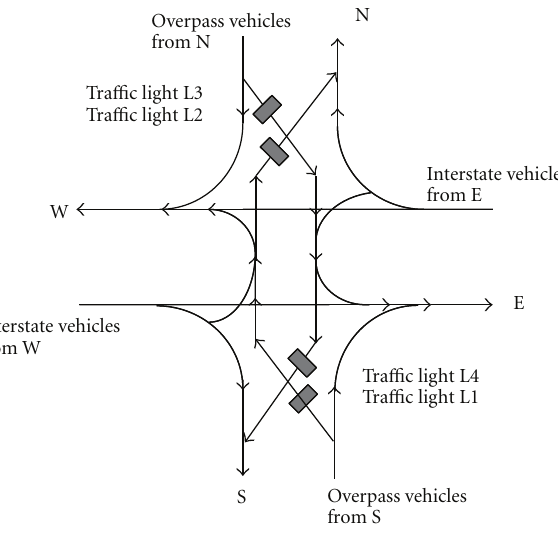
Figure 2: Diverging diamond